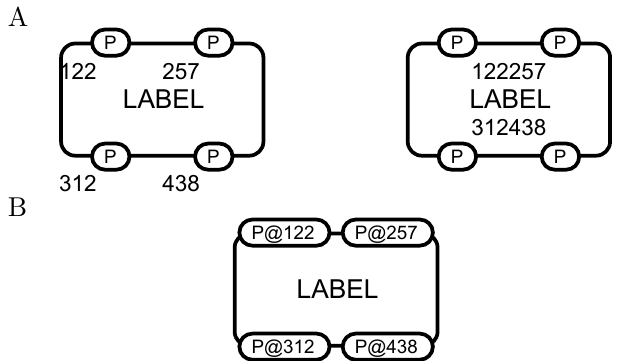
Figure 2.4: A. Examples of discouraged use of state variables . B. Encouraged